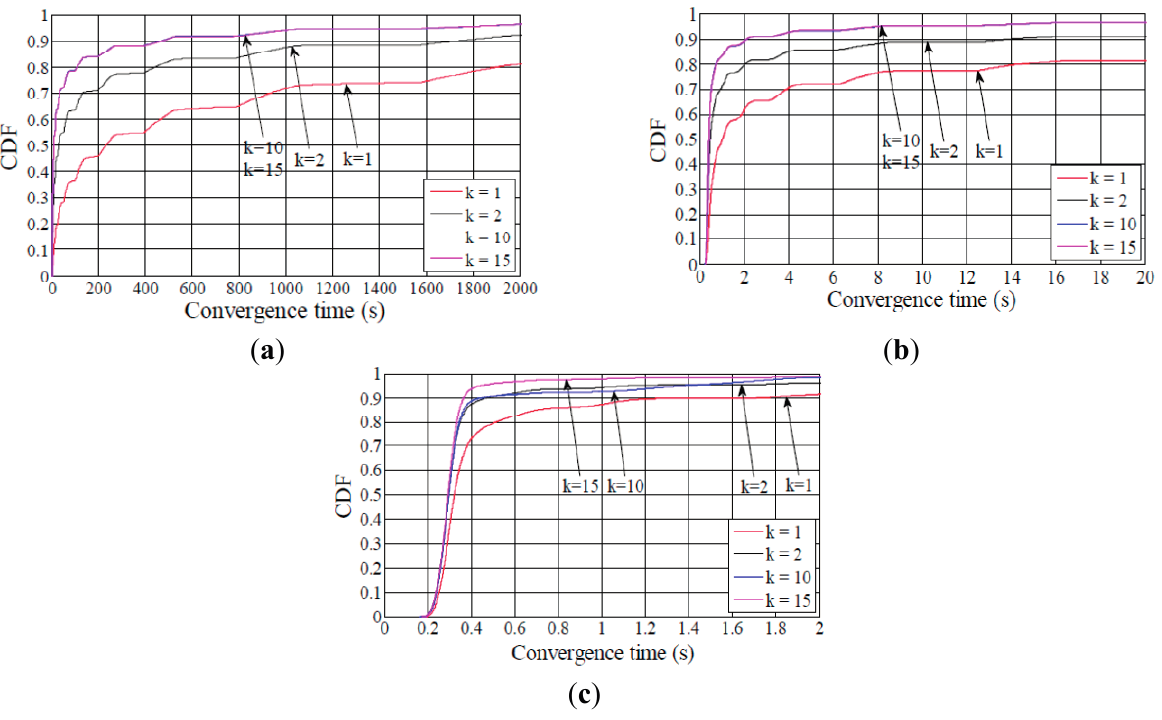
Figure 7. CDF of network convergence time in the large network size scenario. The average node degrees are 5, 10 and 15 in figures ( a ), ( b ) and ( c ), respectively.